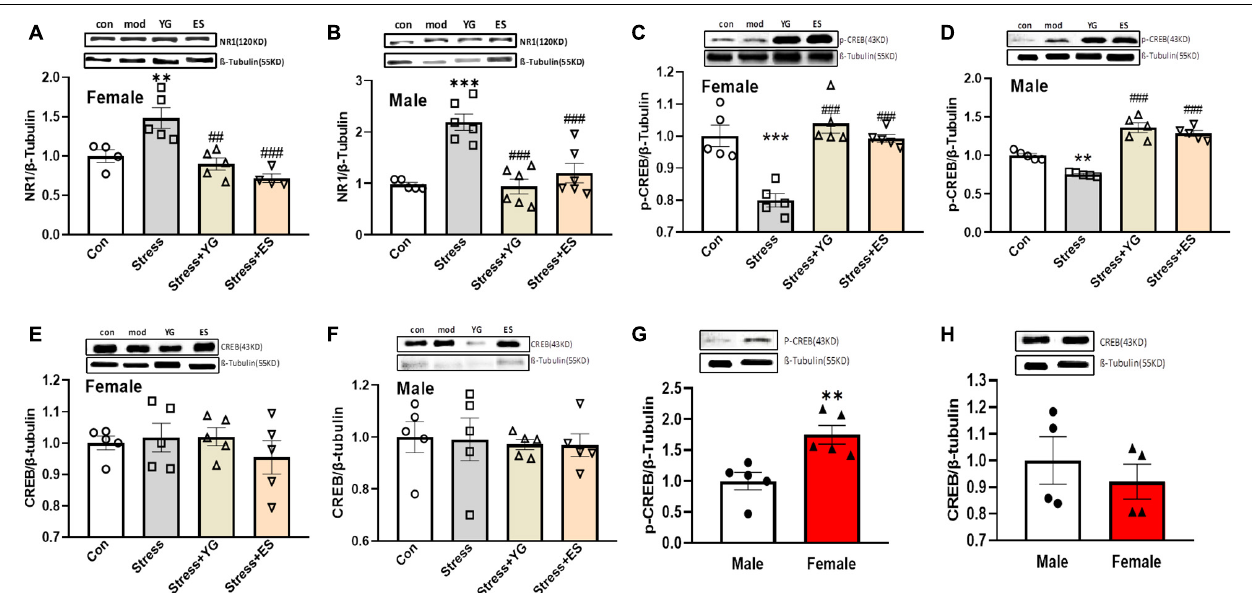
FIGURE 7 | NR1, pCREB, and CREB expression in the hippocampus after chronic subthreshold dosage administration of YG and ES in CUS mice. (A) NR1 expression in female mice after CUS or drug treatment. (B) NR1 expression in male mice after CUS or drug treatment. (C) pCREB expression in female mice after CUS or drug treatment. (D) pCREB expression in male mice after CUS or drug treatment. (E) CREB expression in female mice after CUS or drug treatment. (F) CREB expression in male mice after CUS or drug treatment. (G) pCREB expression in normal female and male mice. (H) CREB expression in normal female and male mice. ∗∗ p < 0.01, ∗∗∗ p < 0.001, compared with the control group; ## p < 0.01, ### p < 0.001, compared with the CUS group, one-way ANOVA, n =